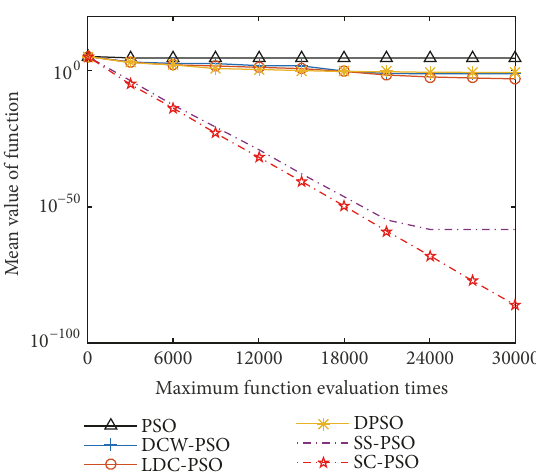
Figure 3: The function f 1 iterates over the